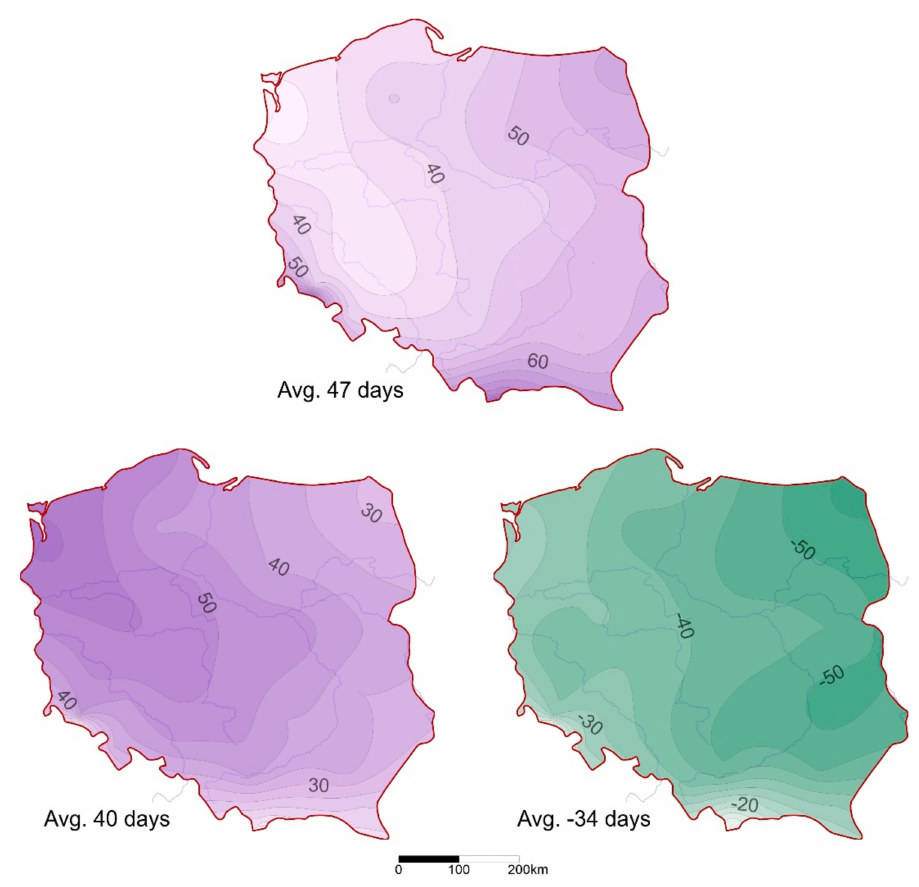
Figure 5. Mean winter number of days with snow cover averaged for winters 1966/1967–2019/2020 ( top ). Anomalies of number of days in extreme winters 1969/1970 ( bottom left ) and 2019/2010 ( bottom right